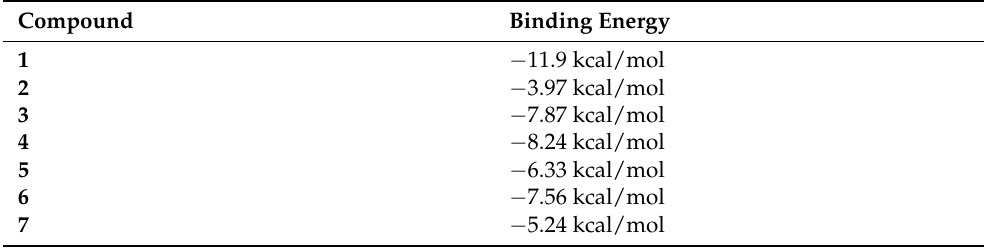
Figure 8. ( A ) PyMOL cartoon representation of the TET1 model (green) showing the secondary structure elements. The zinc ions are displayed as gray spheres, and the active-site ferrous ion is shown in orange. The best docking pose of compound 1 (displayed as a blue stick structure) in the TET1 structural model is also shown. ( B ) Close-up view of the TET1 active site showing docked compound 1 in a sphere representation. The Fe(II) ion is displayed as a crossed orange sphere, and the protein residues involved in contacts with compound 1 are shown as pink sticks. The hydrogen bonds and carbon hydrogen bond are indicated by gray lines. Table 2. Computed value of binding energy between compounds 1 – 7 and the TET1 protein.